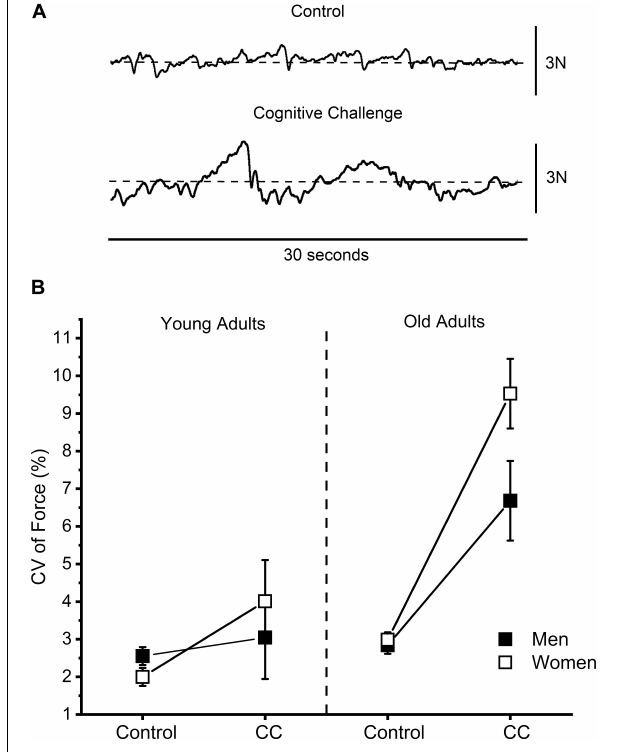
FIGURE 1 | (A) Representative force signals of the elbow flexor muscles for control and cognitive challenge trials (subtracting by 13 from a four-digit number). (B) Force steadiness quantified as the coefficient of variation (CV) of force during the control and cognitive challenge trials (CC) of young and older men and women. Older adults had a greater increase in CV of force (i.e., reduced force steadiness) during the CC trials than young adults ( P <